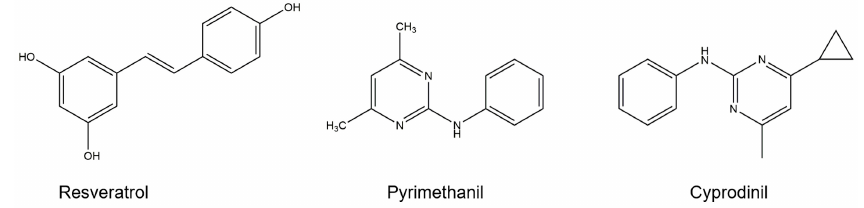
Figure 4. Chemical structures of resveratrol and two tested fungicides.